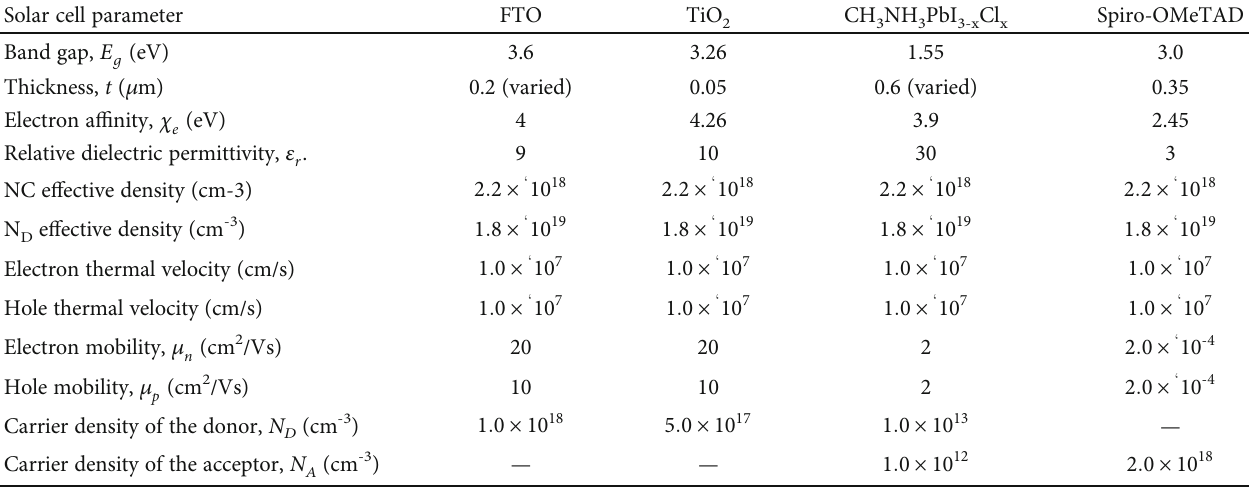
Table 1: Layer parameters used for simulation Perovskite solar cells.